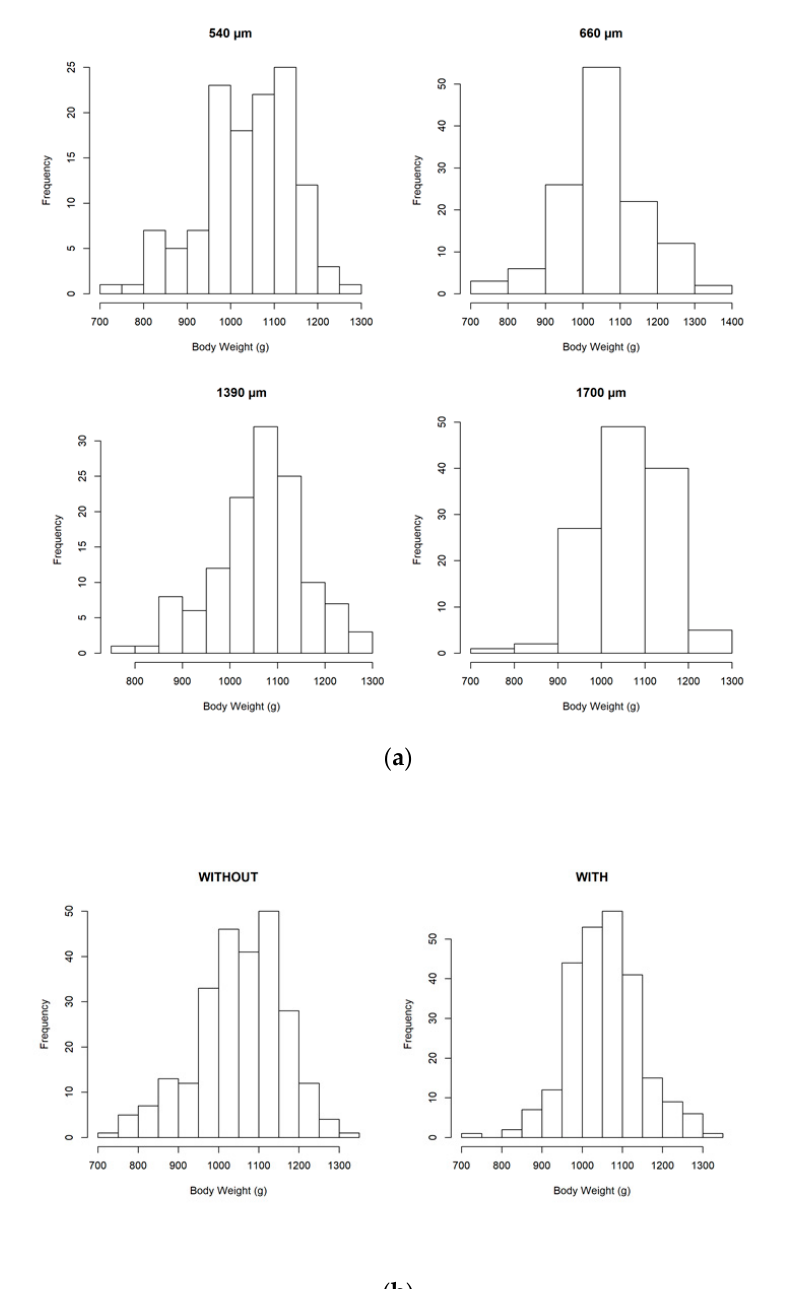
Figure 3. Effect of particle size ( a ) and xylanase inclusion ( b ) on the distribution of body weight